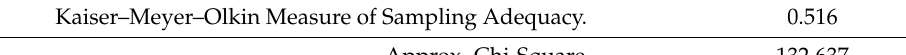
Table 1. KMO and Bartlett’s Test.